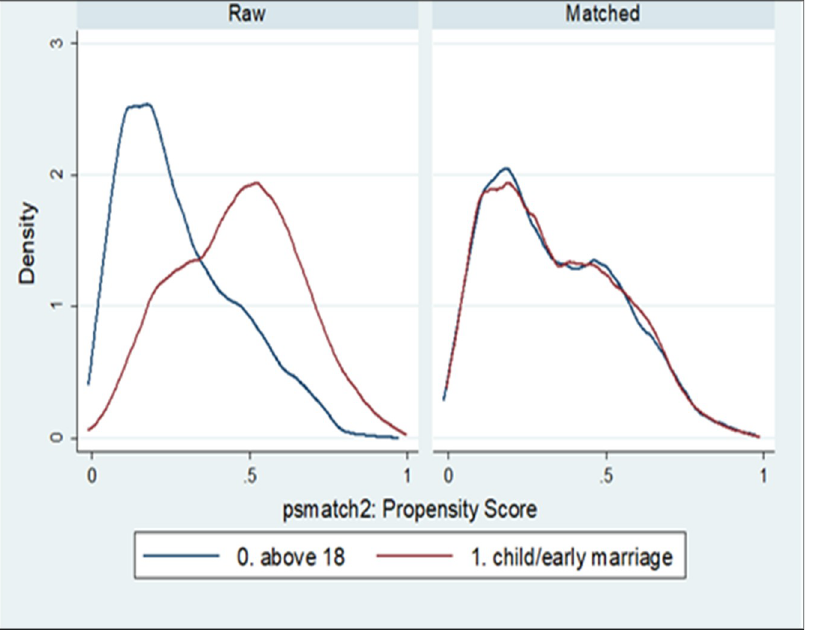
Fig 2. The distributions of the estimated propensity scores for the early and late marriage participants before and after matching.